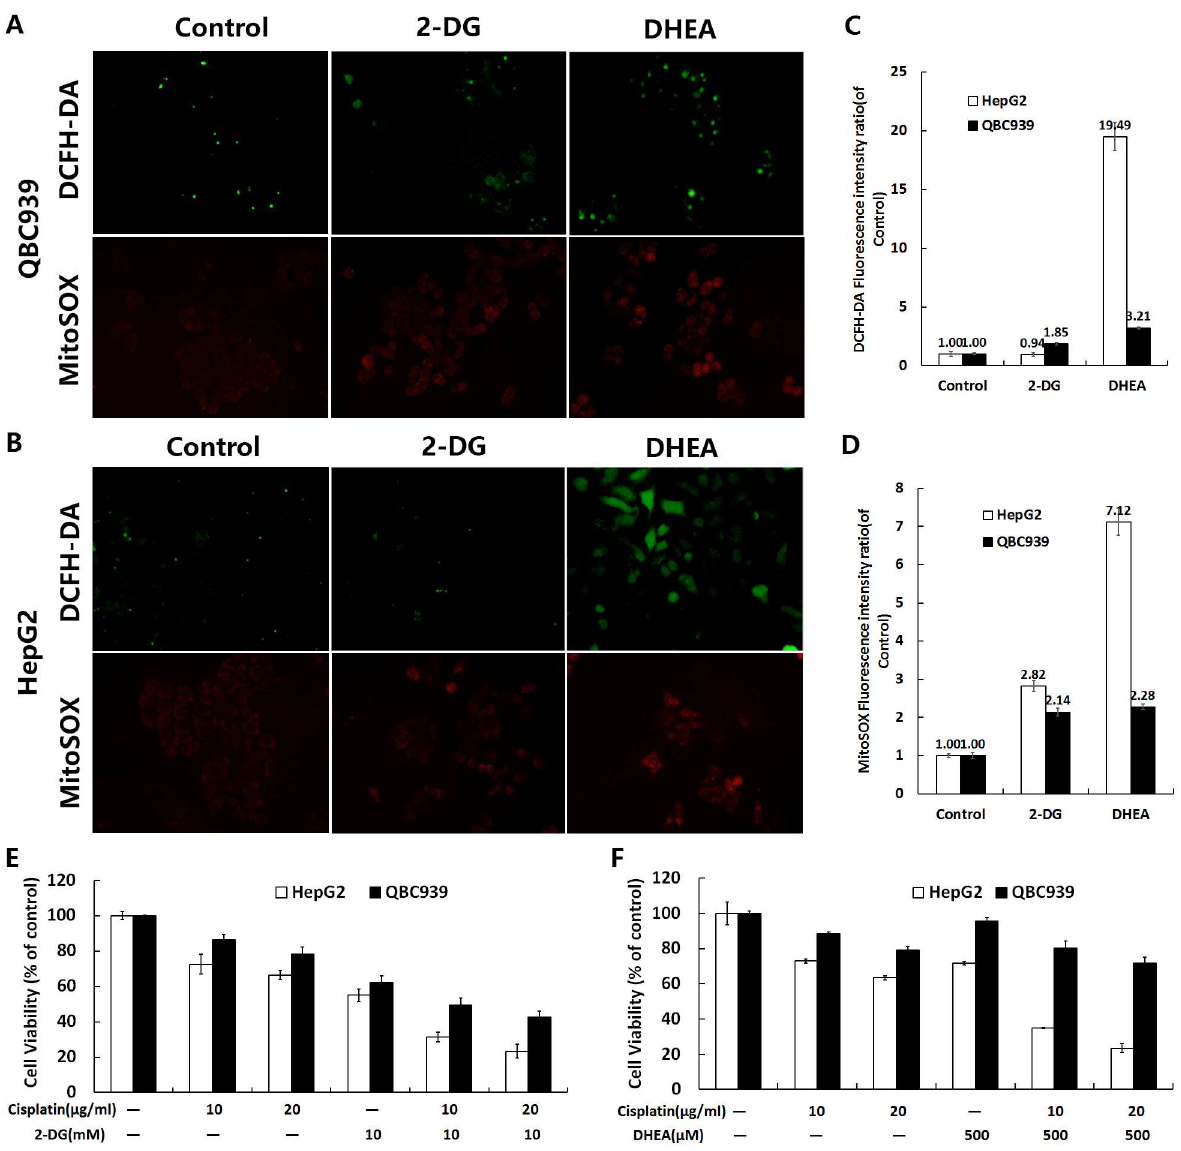
Fig 4. Inhibition of glucose metabolism reduces the antioxidant capacity of QBC939 cells. Cells were treated with 20 mM 2-DG and 500 μ M DHEA for 24 h and assayed for changesin the level of overallROS and mtROS in (A) QBC939 cells and (B) HepG2 cells ( × 200). Quantitation of the cell averagefluorescence intensity of (C) DCFH-DA and (D) MitoSOX under the same treatment conditions as in (A) and (B). Cells were treated with (E) 10 mM 2-DG or (F) 500 μ M DHEA, alone or with the combination of cisplatin (10 or 20 μ g/ml) respectively,for 24 h and then analyzedby MTT assays to detect cell viability. All values are the mean ±